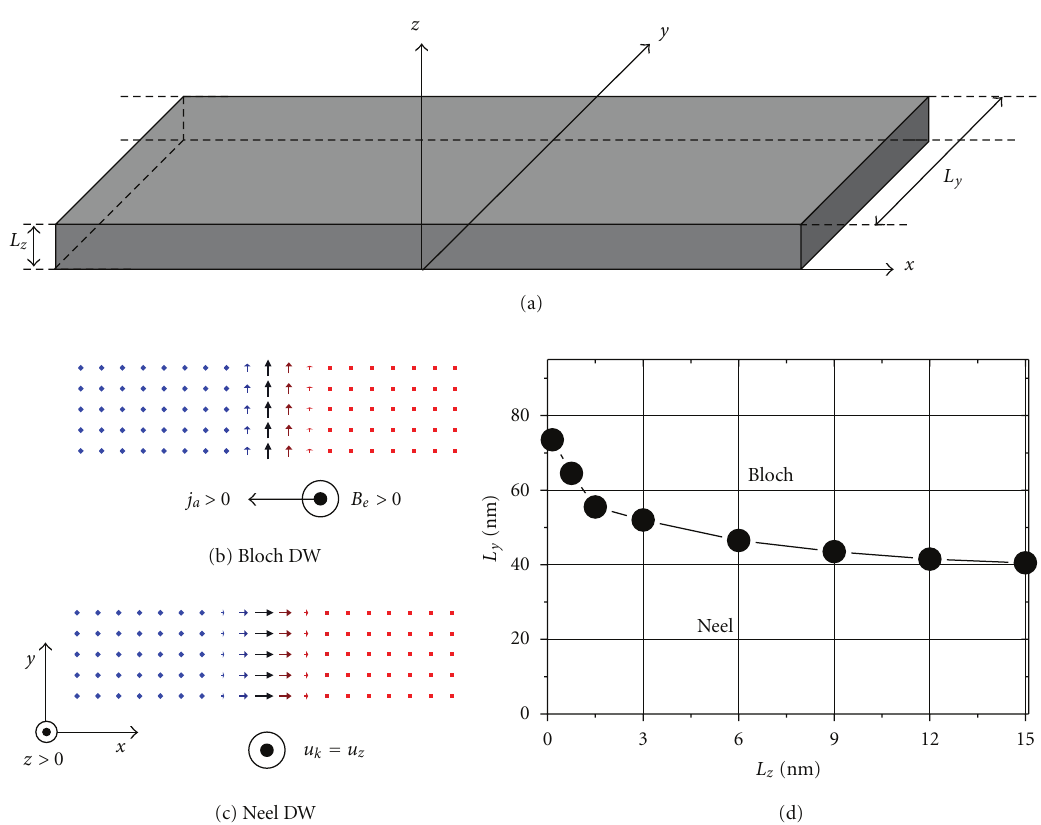
Figure 1: (a) Scheme of the rectangular cross-section strip geometry. Equilibrium states for a DW in thin CoPtCr strips: (b) Bloch, (c) Neel. (d) Phase diagram of the equilibrium state as a function of the width L y and the thickness L z of the strip (from [41]).